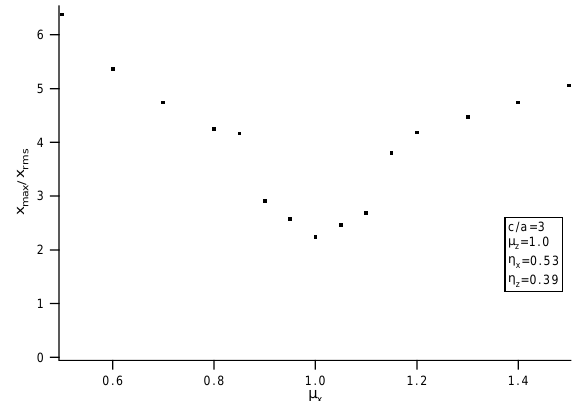
(APT) design [18]. For example, for the short bunch with (cid:99) (cid:121) (cid:97) (cid:173) (cid:50) , with only a longitudinal initial mismatch ( m (cid:122) (cid:173) (cid:49)(cid:46)(cid:53)(cid:44) m (cid:120) (cid:173) m (cid:121) (cid:173) (cid:49)(cid:46)(cid:48) ), one finds particles at large